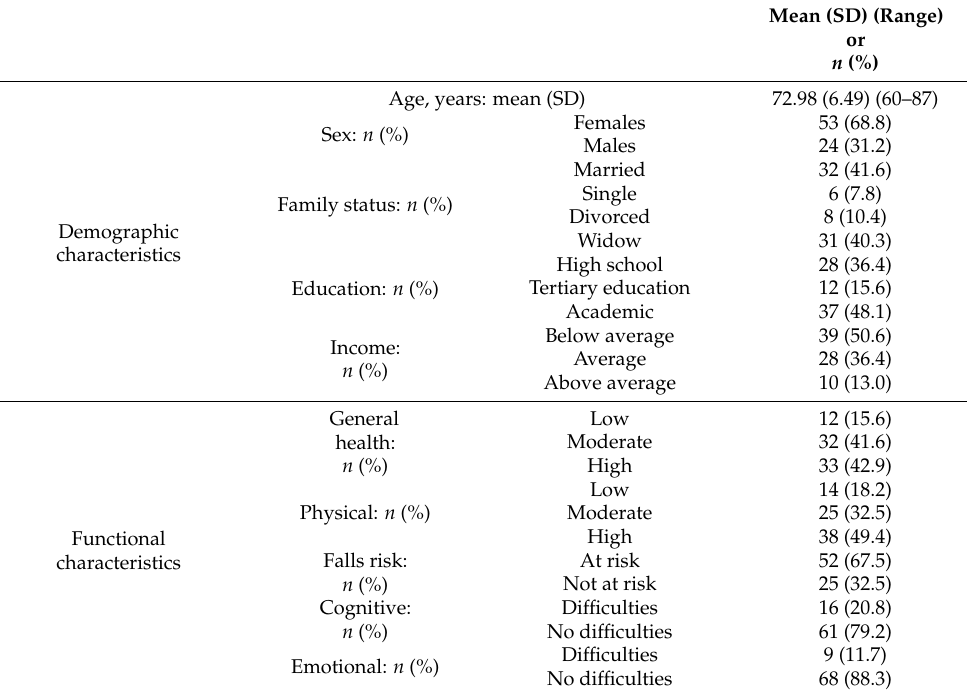
Table 1. Demographic and functional characteristics of study participants ( n = 77).